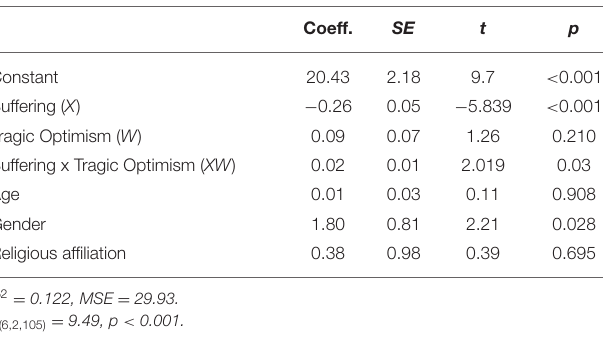
TABLE 3 | Results from a moderation analysis.